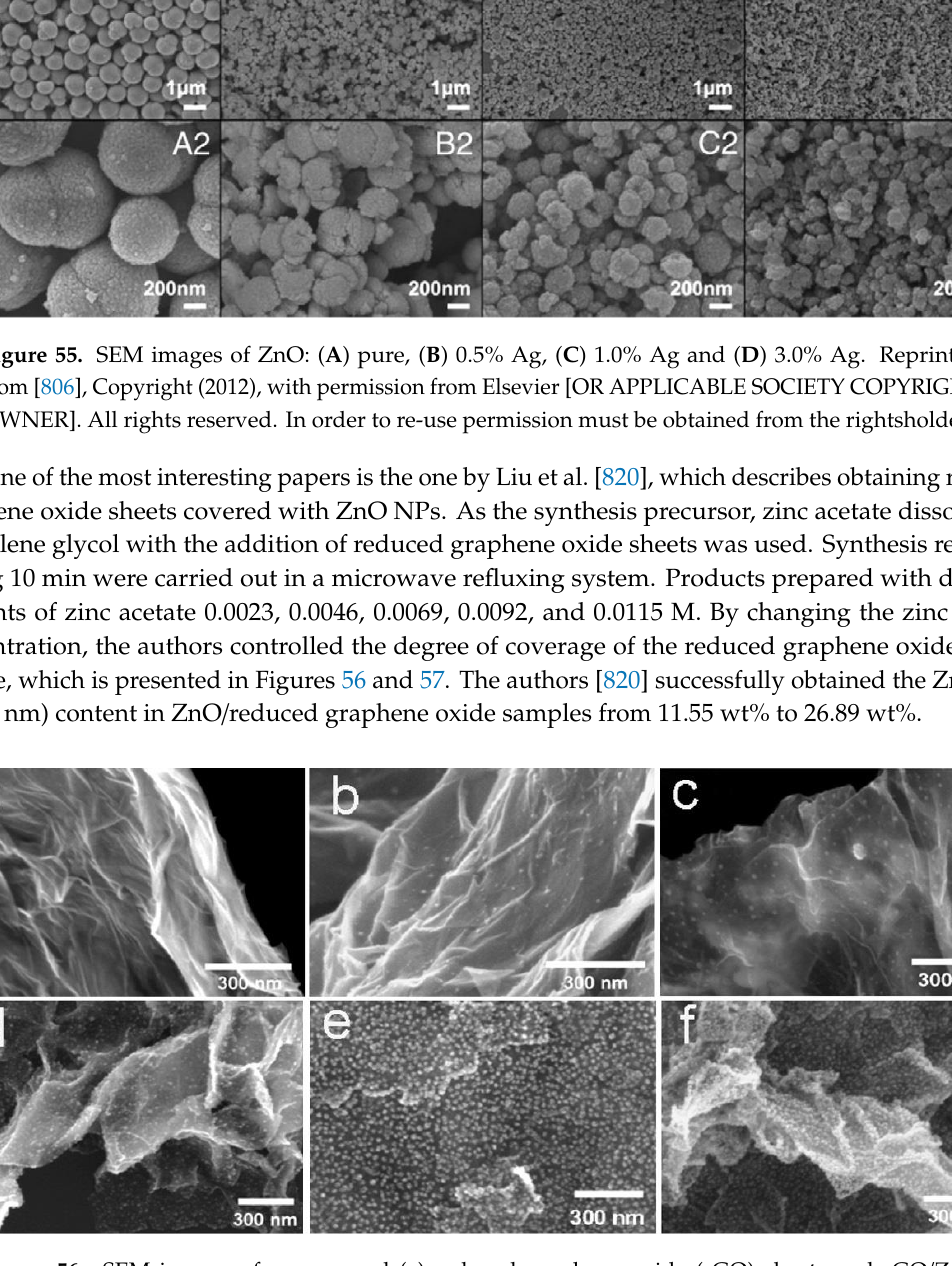
Figure 56. SEM images of as-prepared ( a ) reduced graphene oxide (rGO) sheets and rGO/ZnO nanohybrids obtained with different concentrations of Zn 2+ : ( b ) 0.0023 M, ( c ) 0.0046 M, ( d ) 0.0069 M, ( e ) 0.0092 M, and ( f ) 0.0115 M. Reprinted from [820], Copyright (2012), with permission from Elsevier must be obtained from the